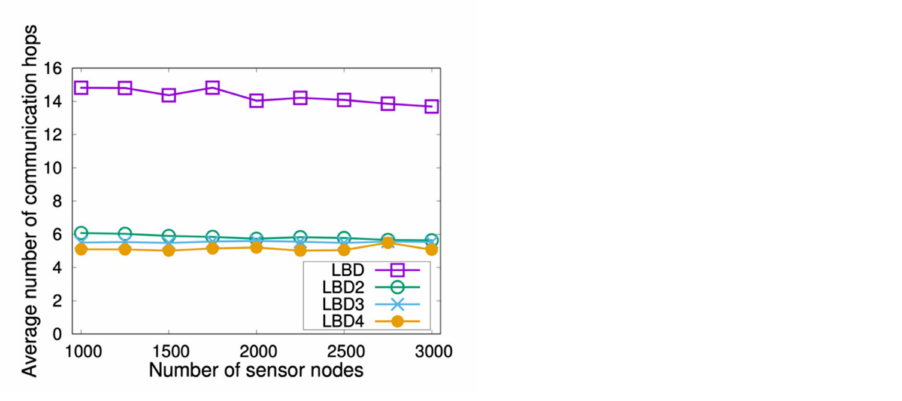
Figure 9. Comparison of the average number of hops for LBD, LBD2, LBD3, and LBD4 as the number of nodes increased.